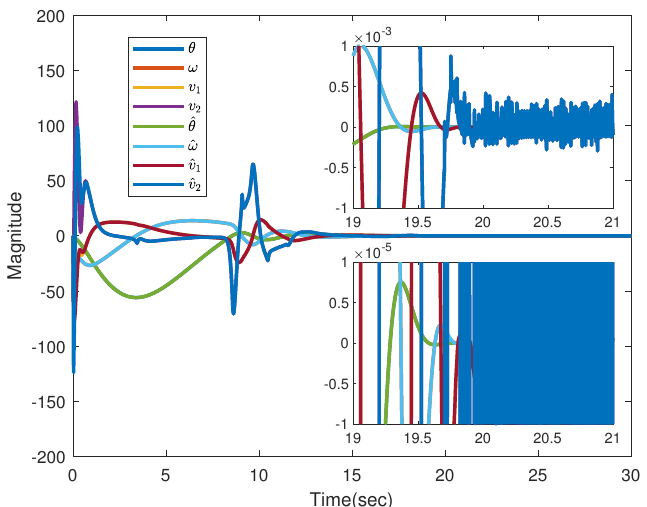
Figure 6. Convergence of the states of the system (20) and the estimates produced by the observer (16) to the origin in the presence of deterministic